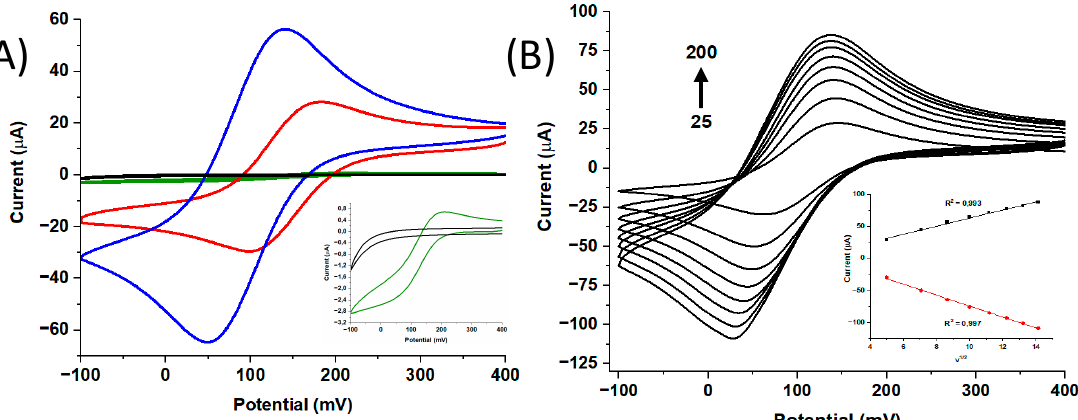
Figure 3. ( A ) CVs recorded in a 5 mmol L − 1 [Fe(CN) 6 ] − 3 solution from +400 to − 100 mV at 75 mV s − 1 scan rate. Blank bare electrode measurement (black line), bare platinum microelectrode (green line), blank CNFs/GNP/Pt electrode measurement (pink line), GNP/Pt (red line), and CNFs/GNP/Pt (blue line). ( B ) Study of the scan rate influence on the peak current performed from 25 to 200 mV s − 1 for the CNFs/GNP/Pt electrode in a 5 mmol L − 1 [Fe(CN) 6 ] − 3 solution. Inset demonstrates the diffusion- controlled process proportionated by the CNFs/GNP/Pt microelectrode utilized in this study.